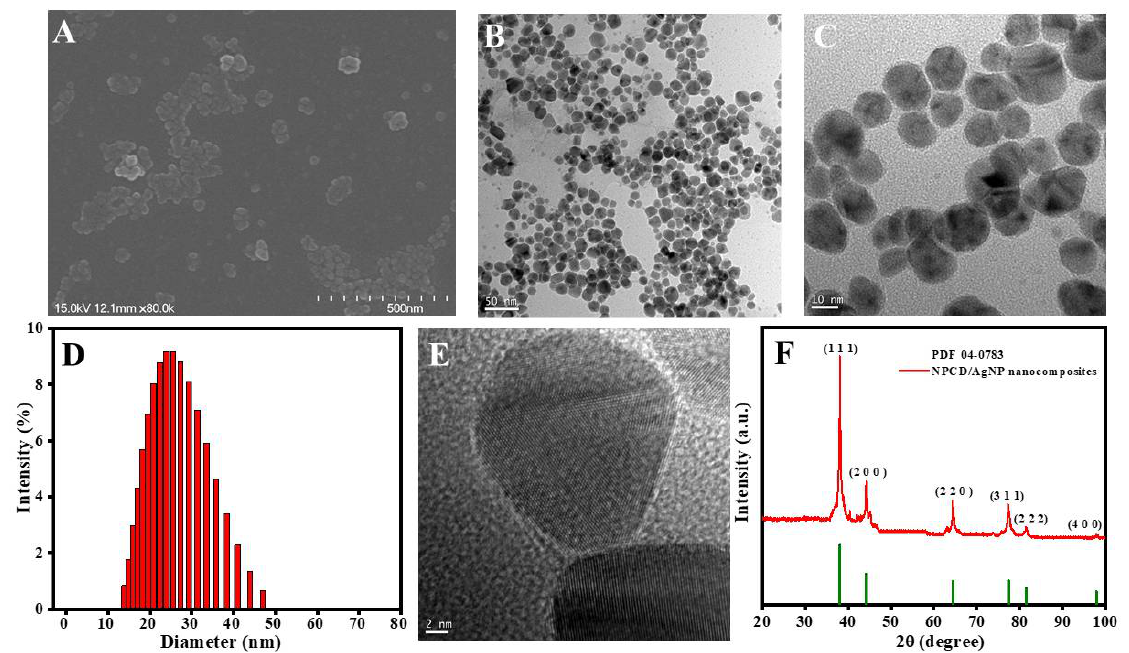
Figure 3. ( A ) SEM image, ( B , C ) TEM images, and ( D ) ELS analysis of the NPCD/AgNP nanocomposites. ( E ) High-resolution TEM image and ( F ) powder XRD pattern of NPCD/AgNP